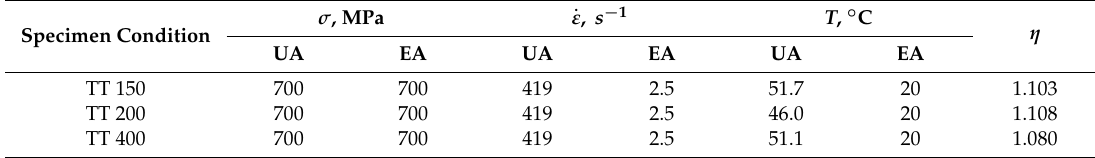
Table 2. Values of experimental parameters for UA and EA specimens and results of η